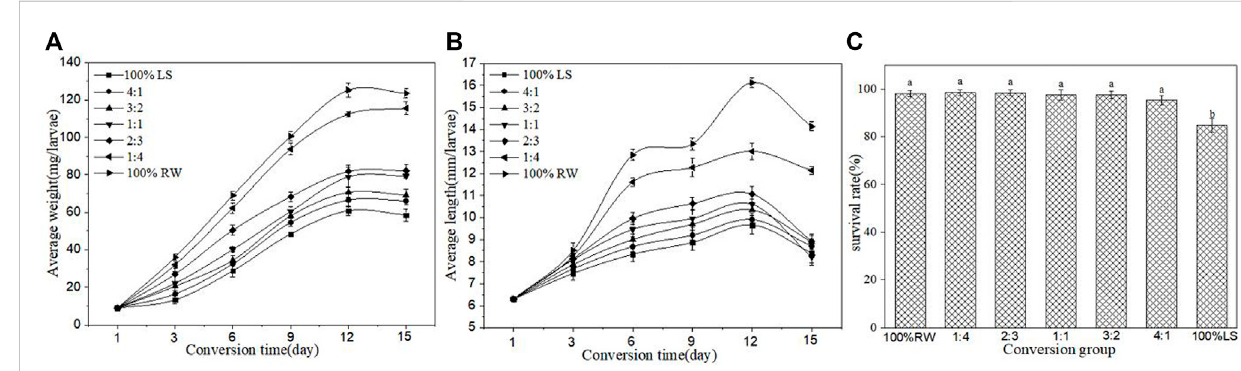
FIGURE 2 Survival rate and the growth of BSFL during the conversion of different proportions of lake sediment and restaurant waste by BSFL. (A) Average weight; (B) Average length; (C) Survival rate. 100% LS:100% lake sediment, 100% RW:100% restaurant waste. Small letters in the fi gure indicate no signi fi cant difference (n=3, P >